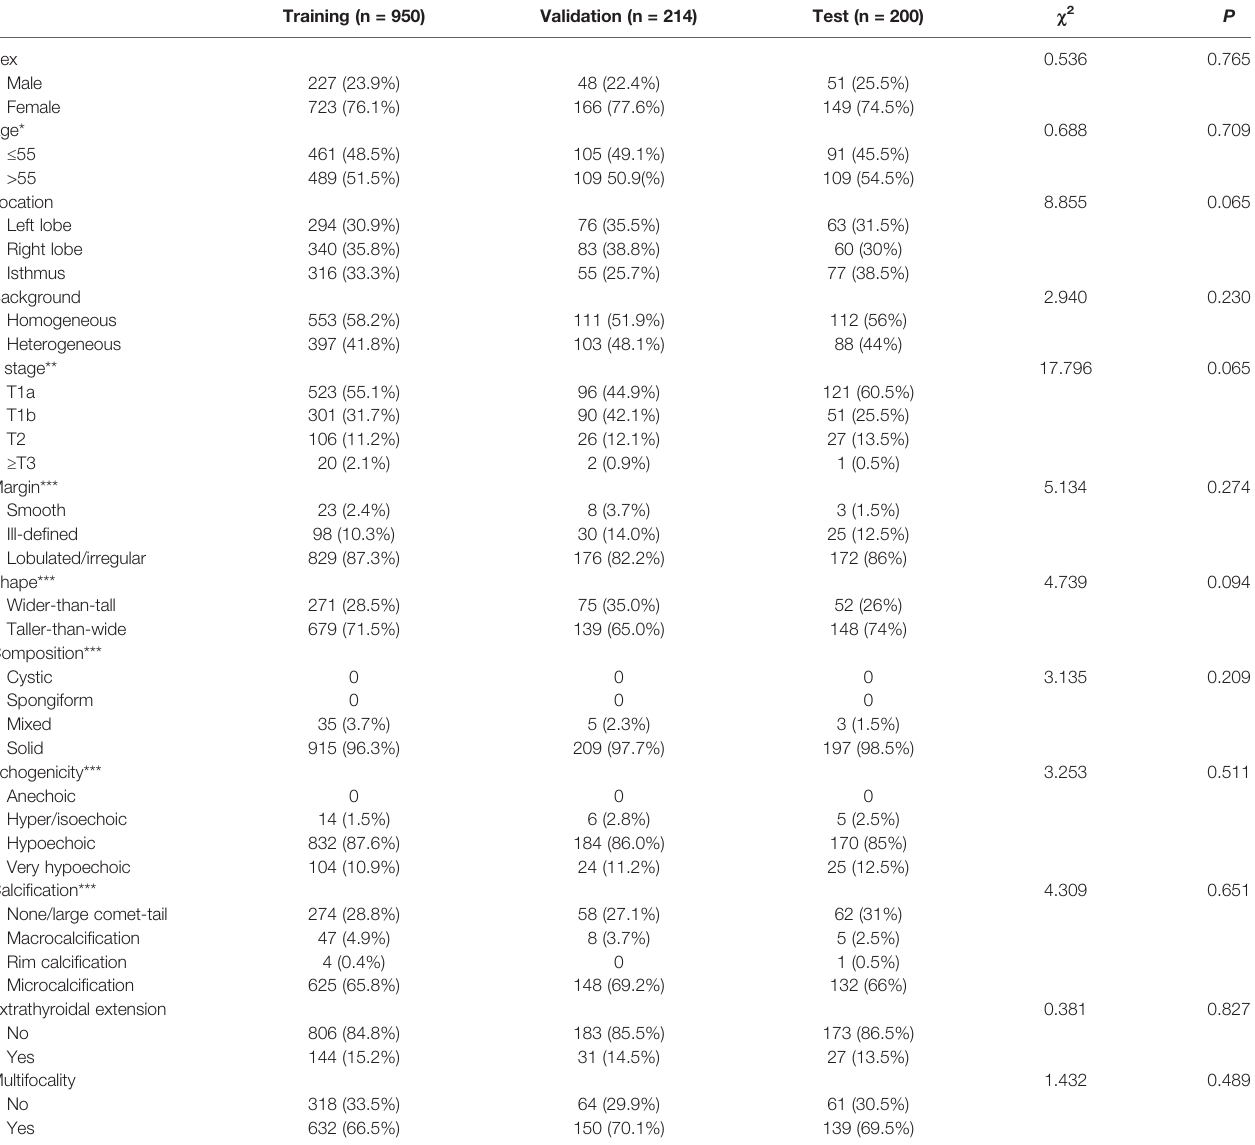
TABLE 1 | Comparison of clinical and ultrasonic characteristics of the PTC patients in the training, validation, and test cohorts. Training (n = 950) Validation (n = 214) Test (n =